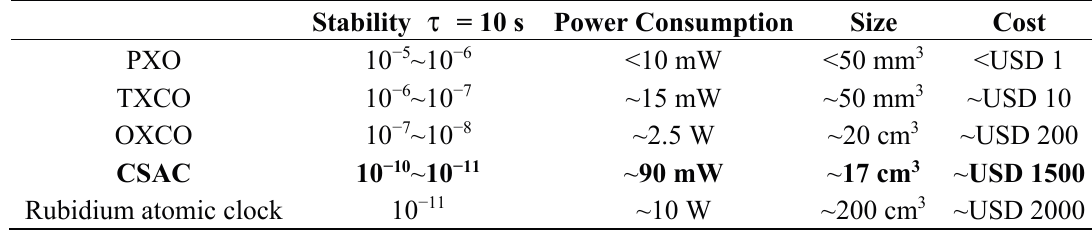
Table 1. Comparisons of different kinds of